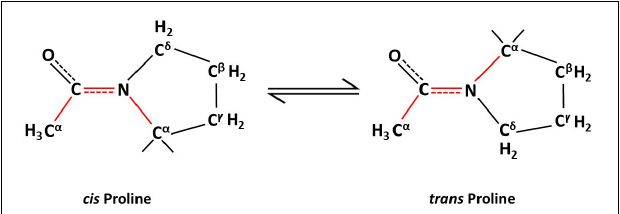
FIGURE 1 | Non-enzymatic proline isomerization within proteins is a slow, rate-limiting process in the folding